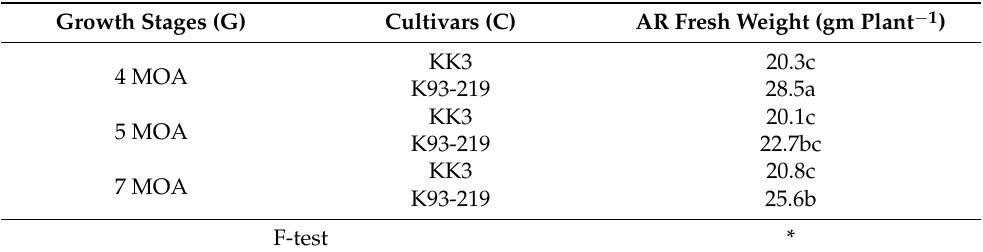
Table 9. Interaction between growth stages and two sugarcane cultivars in fresh adventitious root weights and adventitious root numbers at 7 days after treatment, Experiment 2.